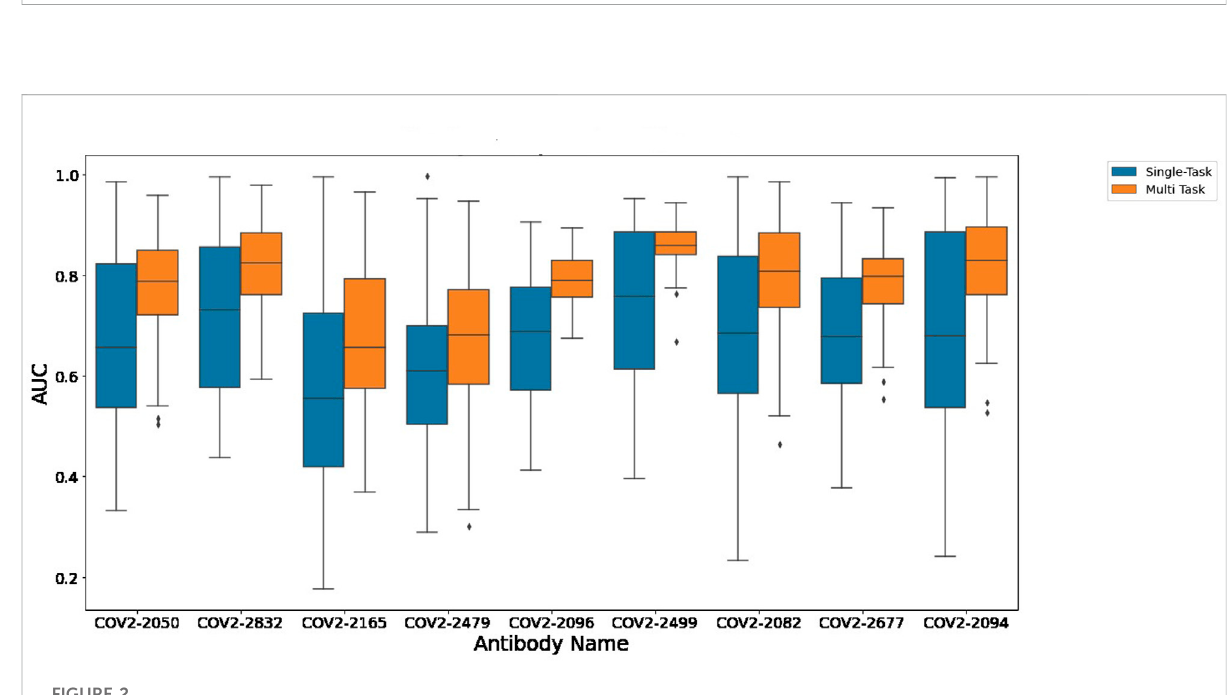
FIGURE 2 A comparison of single-task and multi-task performance in binary escape